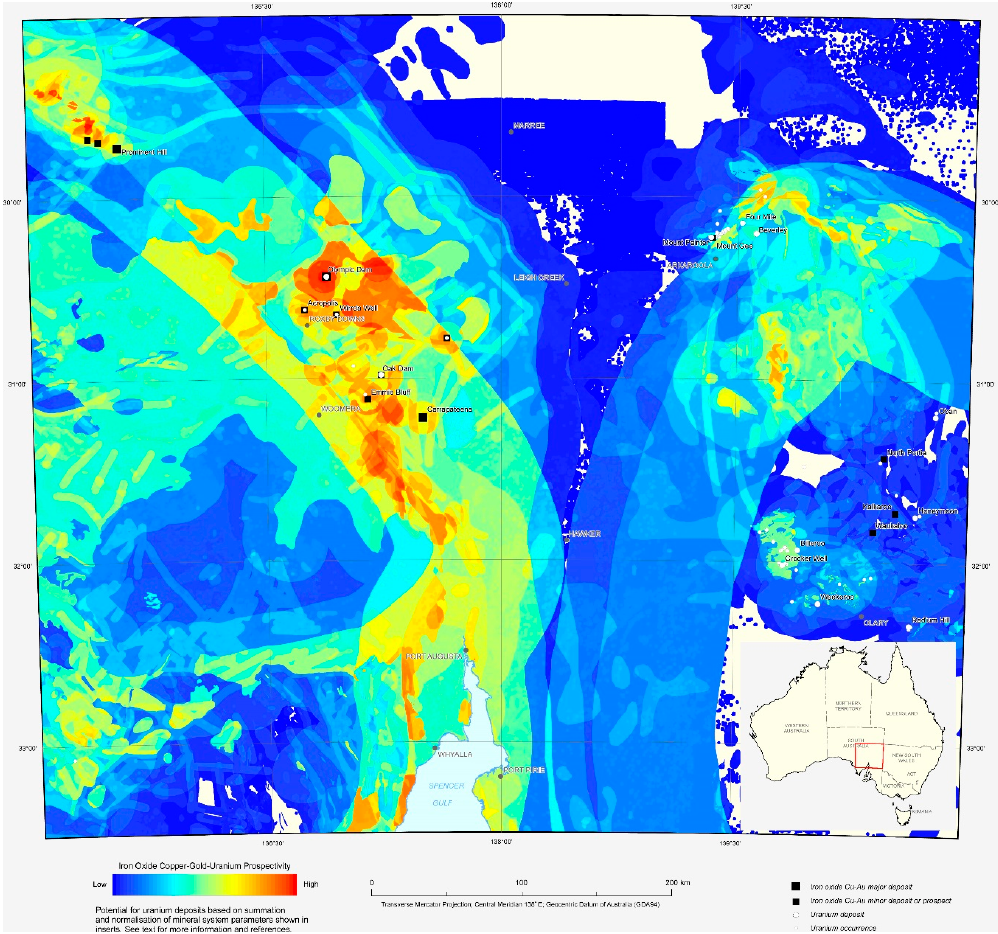
Figure 14. Prospectivity map for uranium-bearing IOCG systems in eastern South Australia (modified from [33]). This map was developed using GIS analysis based on spatial proxies for the four key